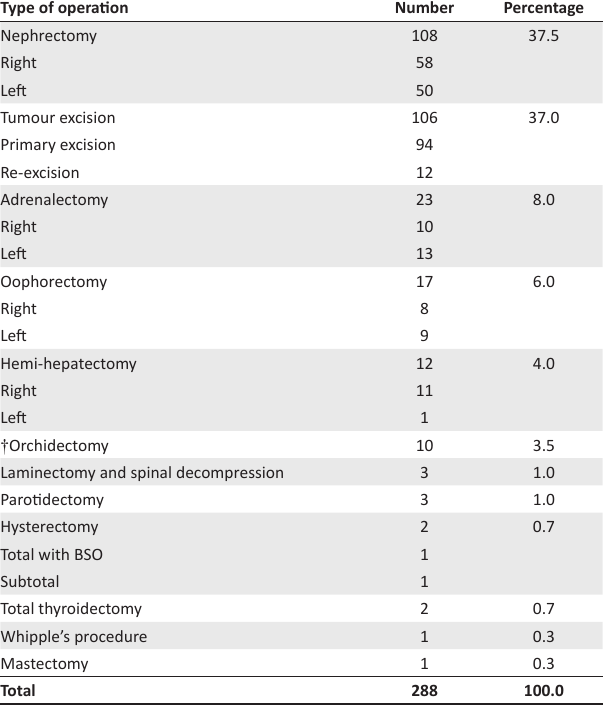
TABLE 3: Oncological surgeries for primary